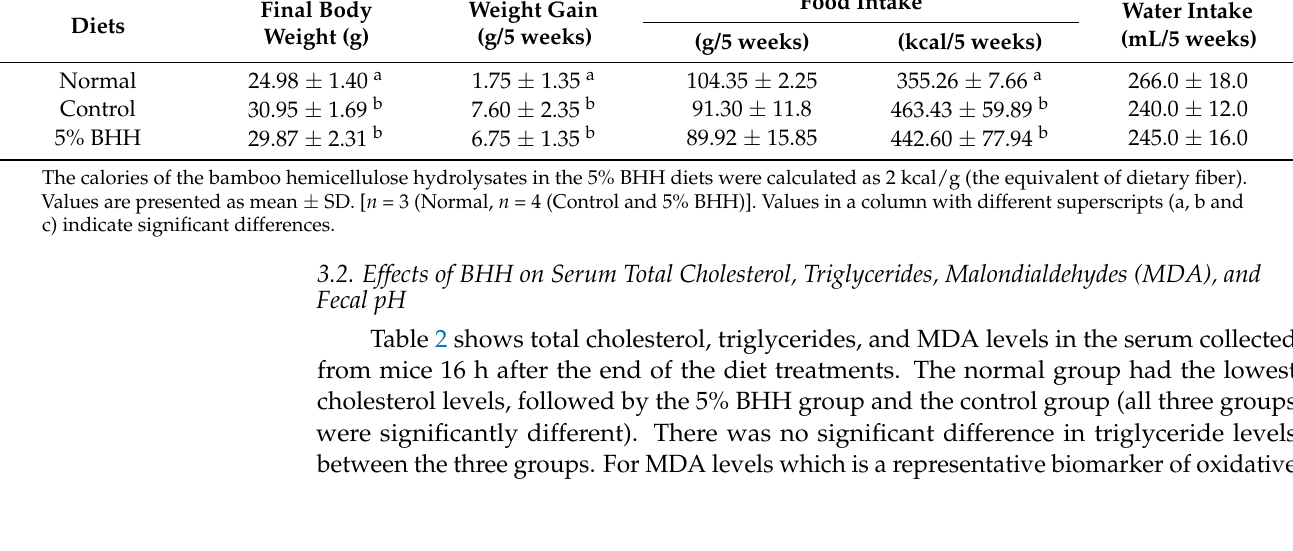
Table 1. Weight gain, final weight, food intake, and water intake in mice fed normal diets (Normal), high-fat diets (Control), or 5% BHH-containing high-fat diets (5% BHH) for 5 weeks.